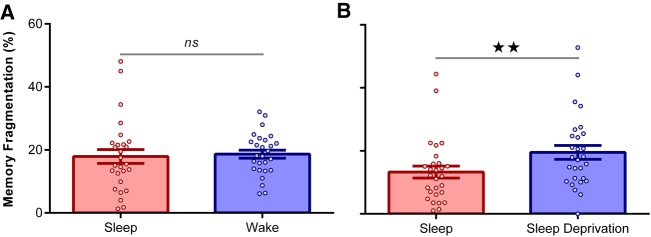
Memory fragmentation. (A) Experiment 1: Memory fragmentation was comparable after a day of wakefulness and a night of sleep. (B) Experiment 2: Memory fragmentation was greater after overnight sleep deprivation relative to sleep. Data points represent individual participants. Data are shown as mean ± SEM. (ns) not significant; (★★) P < 0.01.